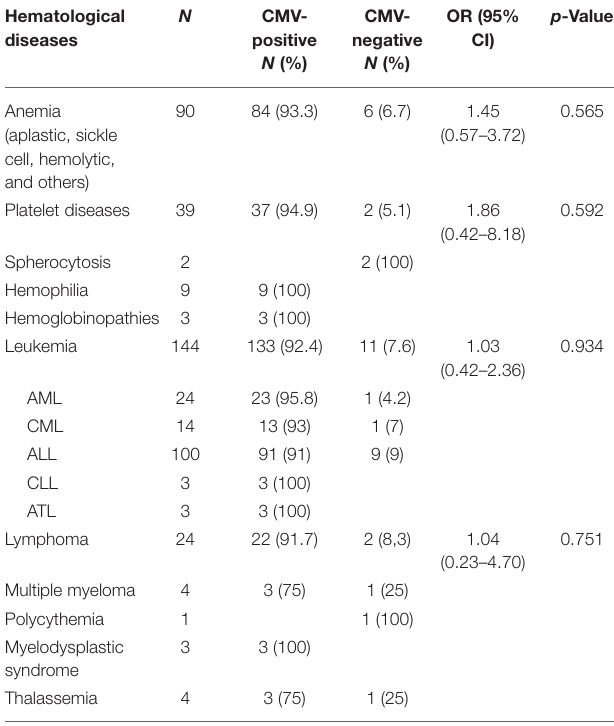
TABLE 1 | Overall prevalence of CMV infection and blood transfusion rates in patients with hematological diseases. Anti-CMV IgG